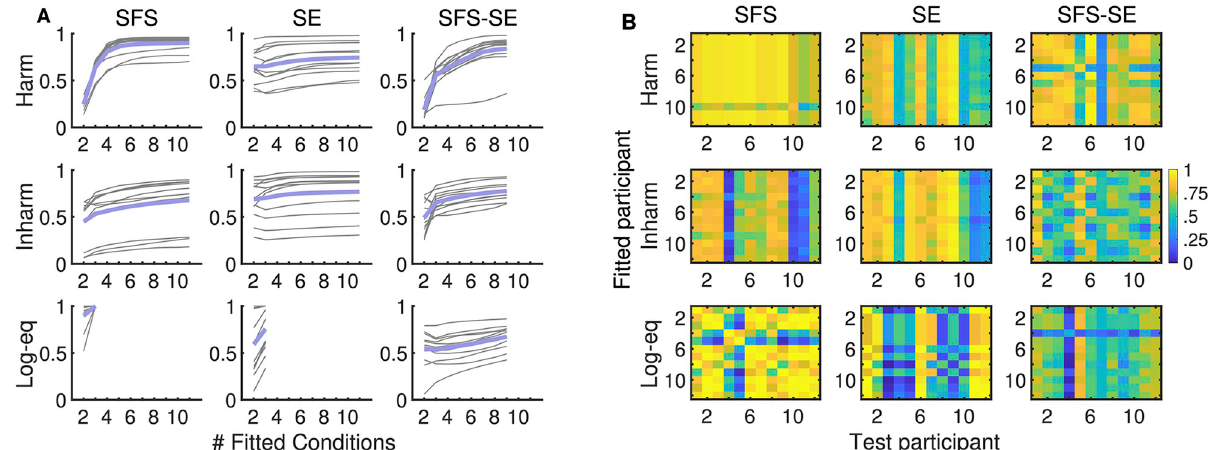
Fig 7. Generalization across shifts and participants. (A) R 2 values of models fitted on a subset of shifts (x-axis) and evaluated on the full set of shifts. Thin gray lines display individual data from individual participants, the thick blue line the average across participants. For every subset of shifts, all possible combinations of subsets were used and the average across all combinations is shown. (B) R 2 values of models fitted for one participant (x-axis) and tested on another participant (y-axis).